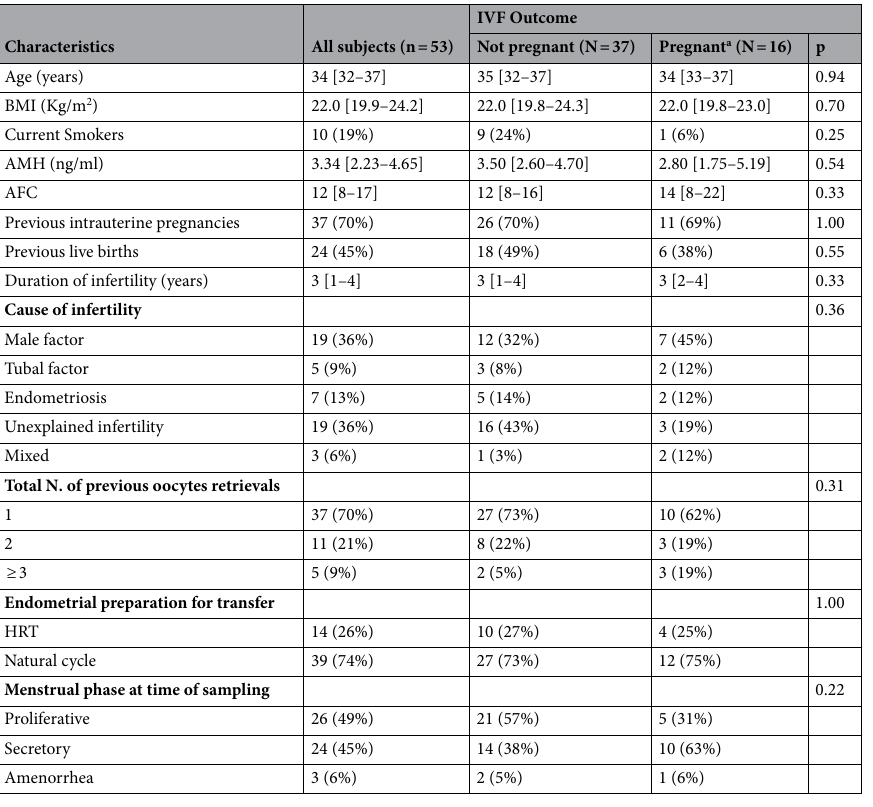
Table 1. Baseline characteritics and cycle outcome of the studied population and of pregnant and non- pregnant women. AFC was obtained in the early menstrual phase at the time of the ovarian hyperstimulation cycle. AMH was assessed regardless of the menstrual phase. Data is reported as number (%), mean ± SD or Median [interquartile range], as appropriate. N Number, BMI Body Mass Index, AFC Antral Follicle Count, AMH Anti-Mullerian Hormone, HRT Hormone Replacement Therapy, IQR Interquartile Range. a All women underwent elective single embryo transfer. Pregnancies that could be obtained with the transfer of additional remaining blastocysts were